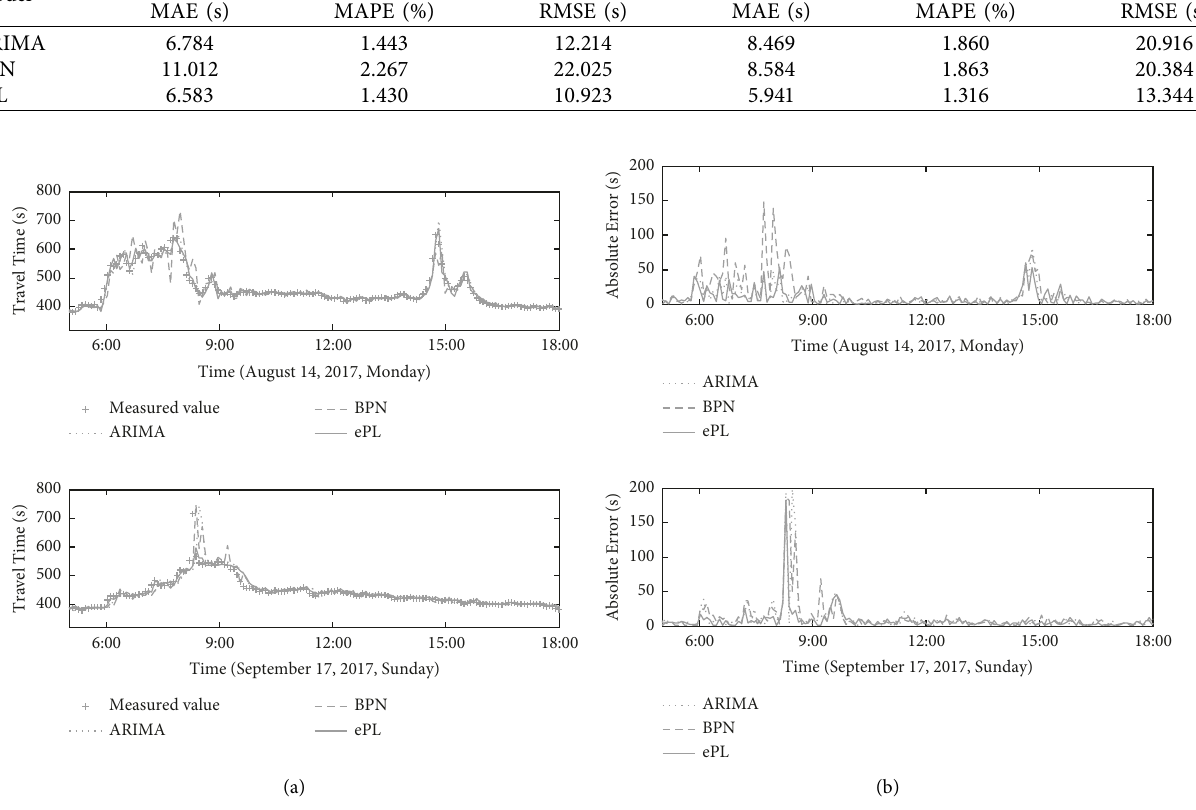
Figure 7: The results of the travel time forecasting with the ePL model. (a) Comparison of several prediction methods with the proposed ePL model. (b) The comparisons of the absolute errors among several forecasting